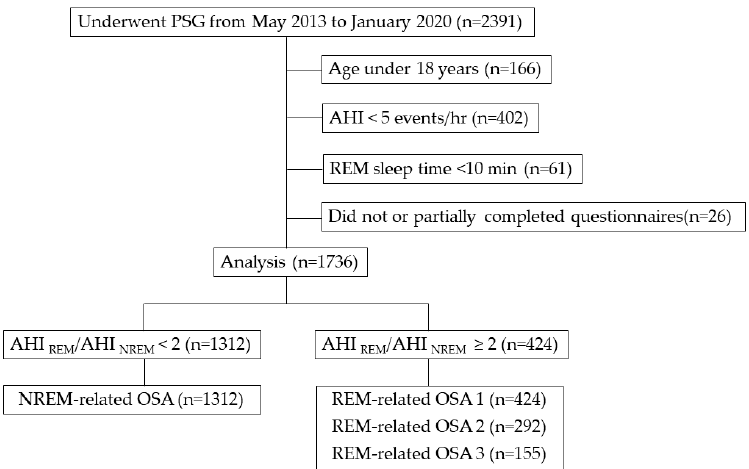
Figure 1. Flowchart of patients who underwent polysomnography ( n = 2391) in this study. PSG, polysomnography; AHI, apnea–hypopnea index; REM, rapid eye movement; NREM, non-rapid eye movement; OSA, obstructive sleep apnea; REM-related OSA 1: overall AHI ≥ 5 and AHI during REM (AHI REM ) / AHI during NREM (AHI NREM ) ≥ 2; REM-related OSA 2: overall AHI ≥ 5, AHI REM / AHI NREM < 15; and REM-related OSA 3: overall AHI ≥ 5, AHI ≥ 2, and AHI NREM and REM sleep duration > 10.5